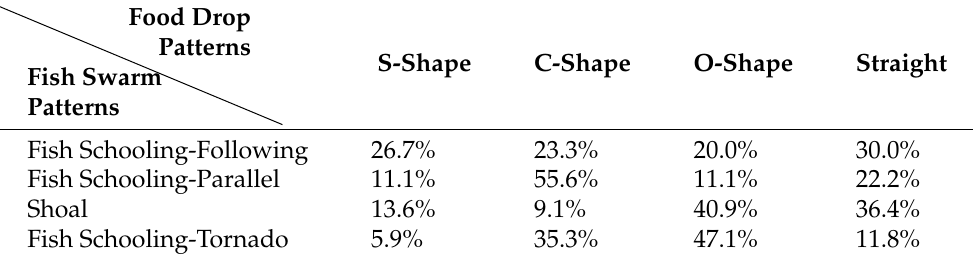
Table 5. Relationship between fish swarm patterns and selected fish-food drop